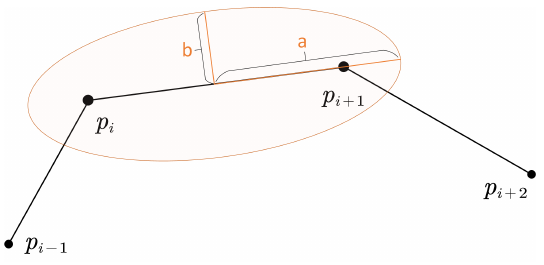
Figure 4. Uncertain ellipse of an interpolated segment.